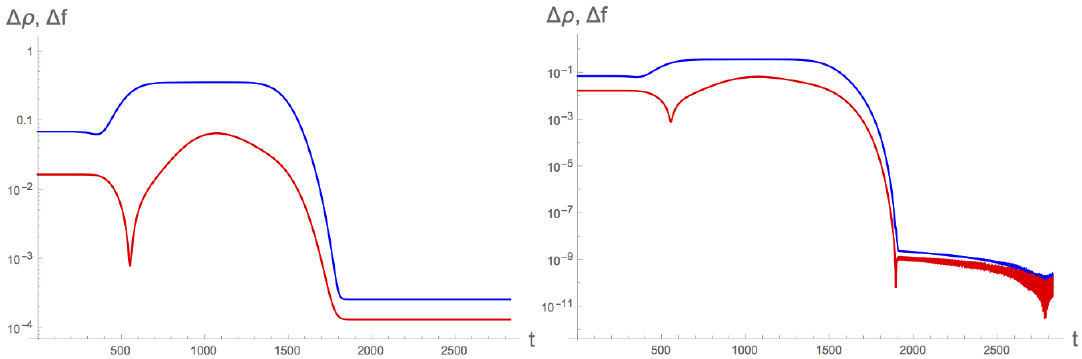
Figure 21 . Time evolution of (cid:1) (cid:26) (blue) and (cid:1) f (red) for the quench process described in the main text. Left: we compare the simulation results to the boson star at the target frequency ! f = 2 : 9. Right: we compare the simulation results to the boson star at the actual frequency ! BS = 2 :